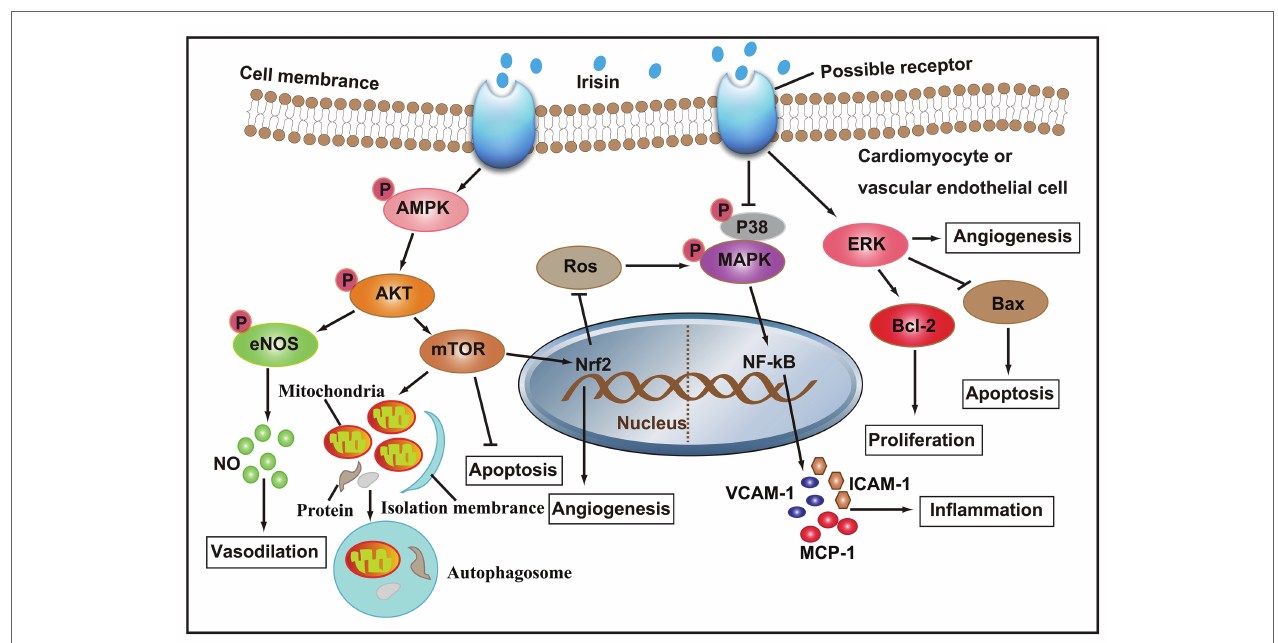
FIGURE 2 | After irisin binds to membrane receptors, AMPK phosphorylation increase, and its downstream Akt/eNOS and Akt/mTOR signaling cascades are activated, thereby promoting NO secretion, autophagy, and angiogenesis, and inhibiting apoptosis and ROS production. On the other hand, irisin can also inhibit the secretion of pro-inflammatory factors by inhibiting p38 MAPK signaling pathway, and promote angiogenesis and cell proliferation, and inhibit apoptosis by activating ERK signaling pathway.